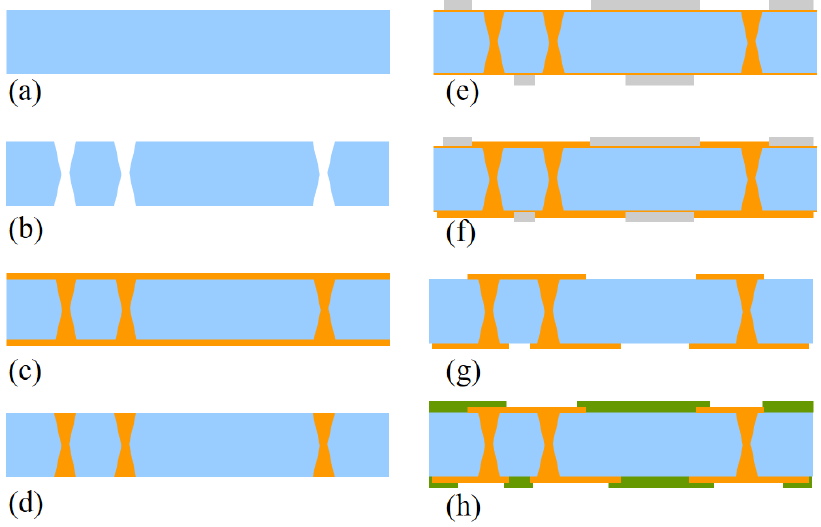
Figure 14. Process flow of TGV full filling. ( a ) wafer preparation, ( b ) TGV formation, ( c ) full side plating, ( d ) annealing and CMP, ( e ) PVD and photolithography, ( f ) plating RDL, ( g ) photoresist strip and Cu/Ti etch, ( h ) passivation formation.